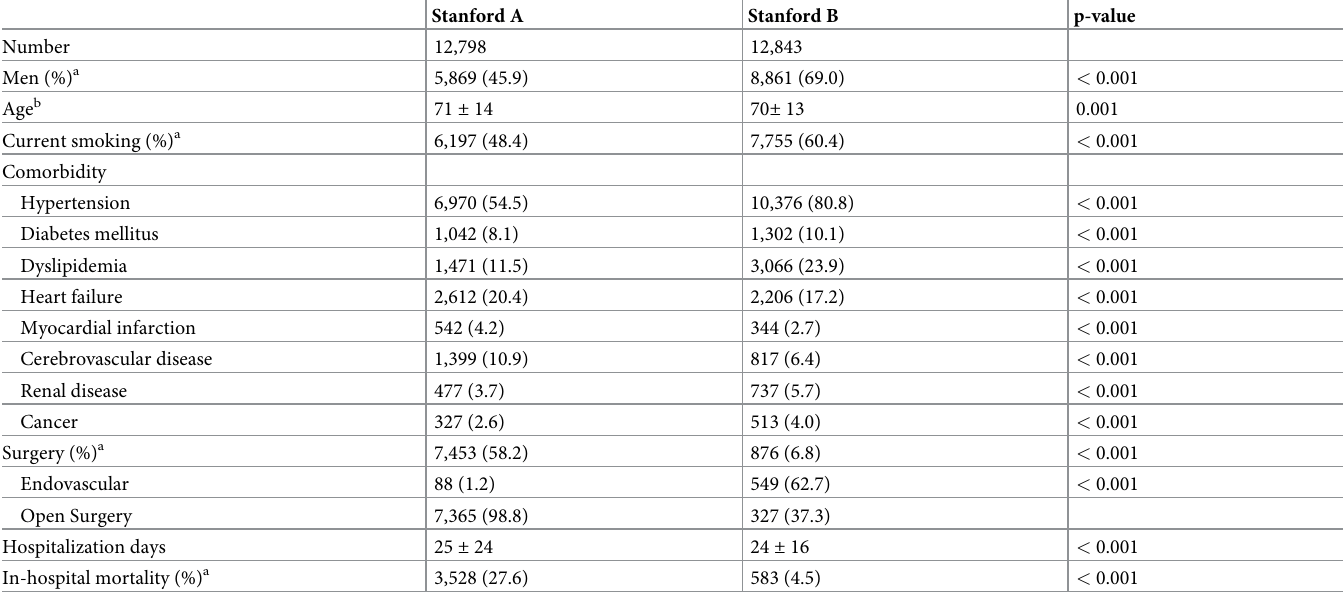
Table 2. Characteristics of patients with acute aortic dissection according to Stanford